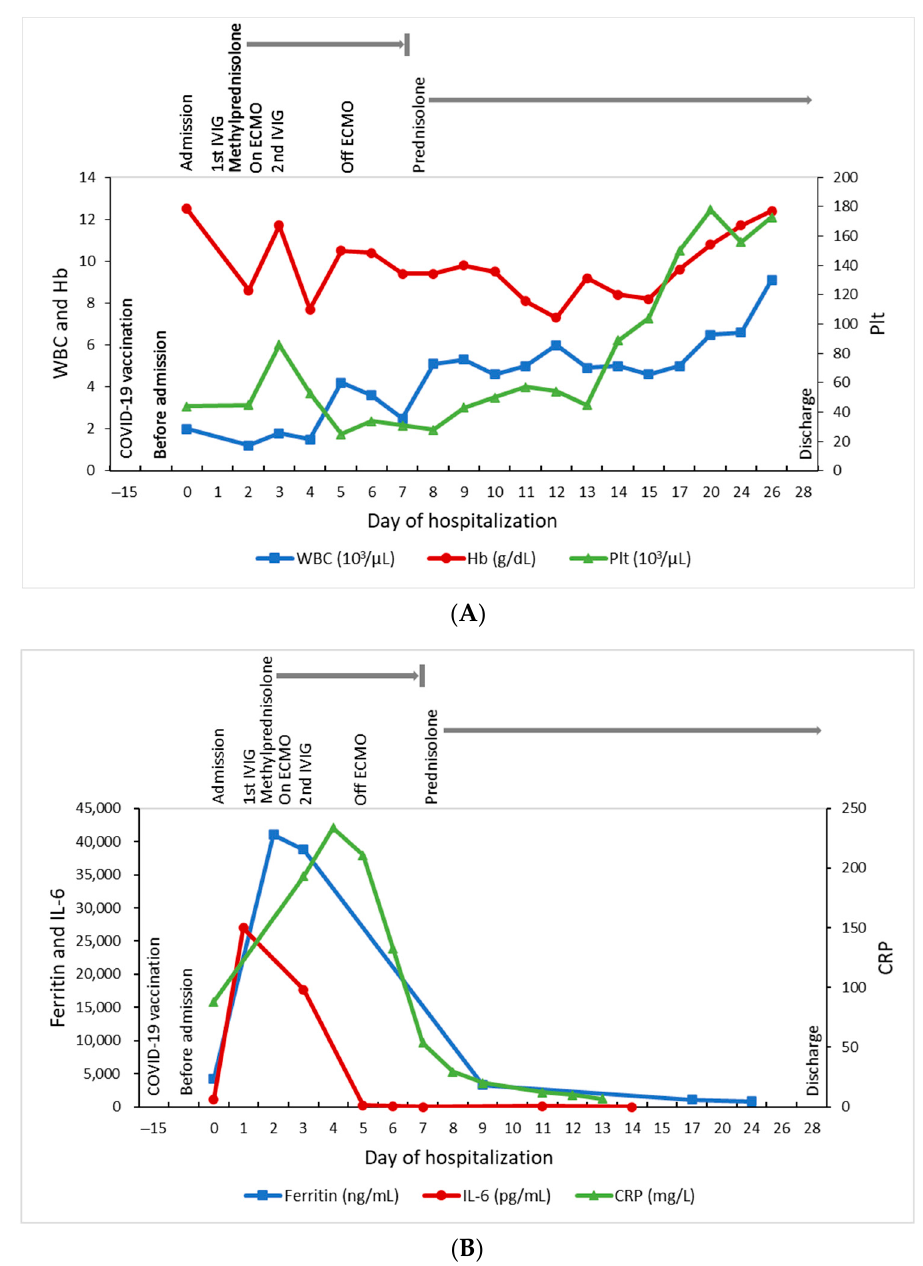
Figure 1. Summary of the clinical course. ( A ) Dynamic changes of the blood cell counts. ( B ) Dynamic changes of the ferritin, IL-6, and CRP levels.